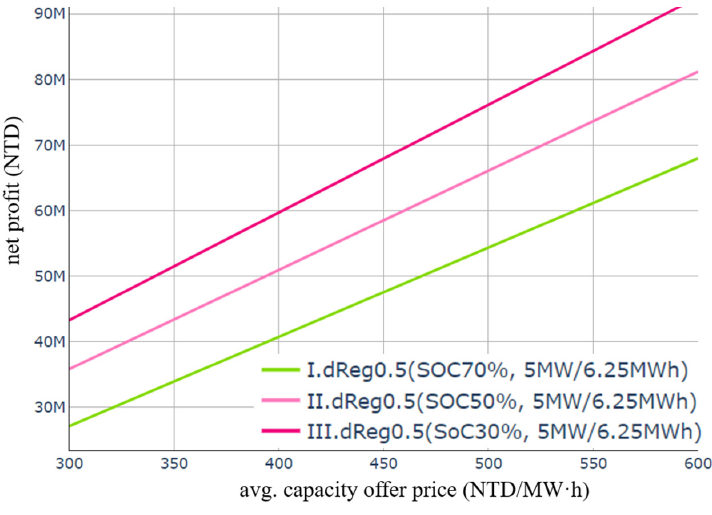
Figure 22. Net profit under different SOC levels (dReg0.5).